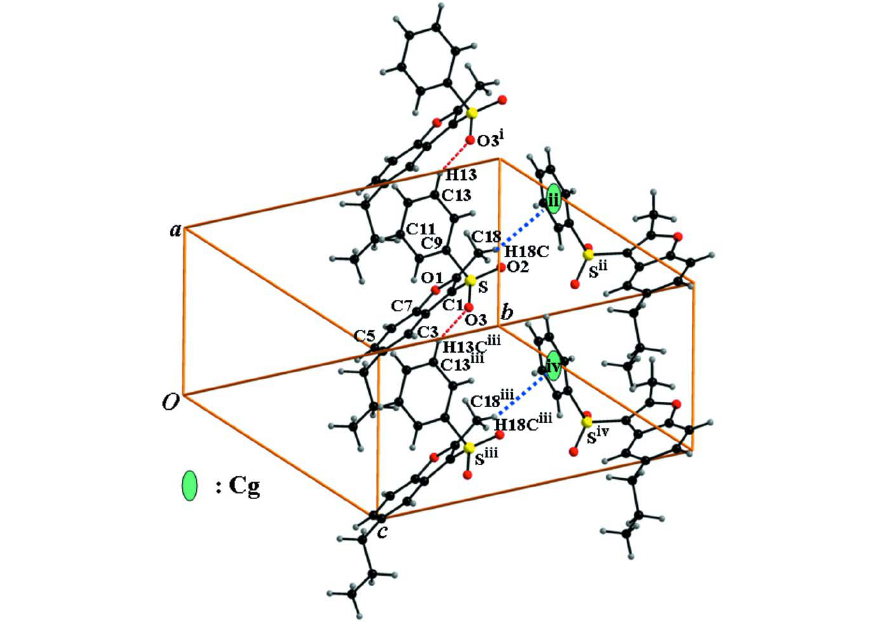
Figure 2 C—H··· π and C—H···O interactions (dotted lines) in the title compound. Cg denotes the ring centroid. [Symmetry code: (i) x + 1, y , z ; (ii) x + 1/2, - y + 3/2, 1/2 + z +1/2; (iii) x - 1, y , z ; (iv) x - 1/2, - y + 3/2, z +